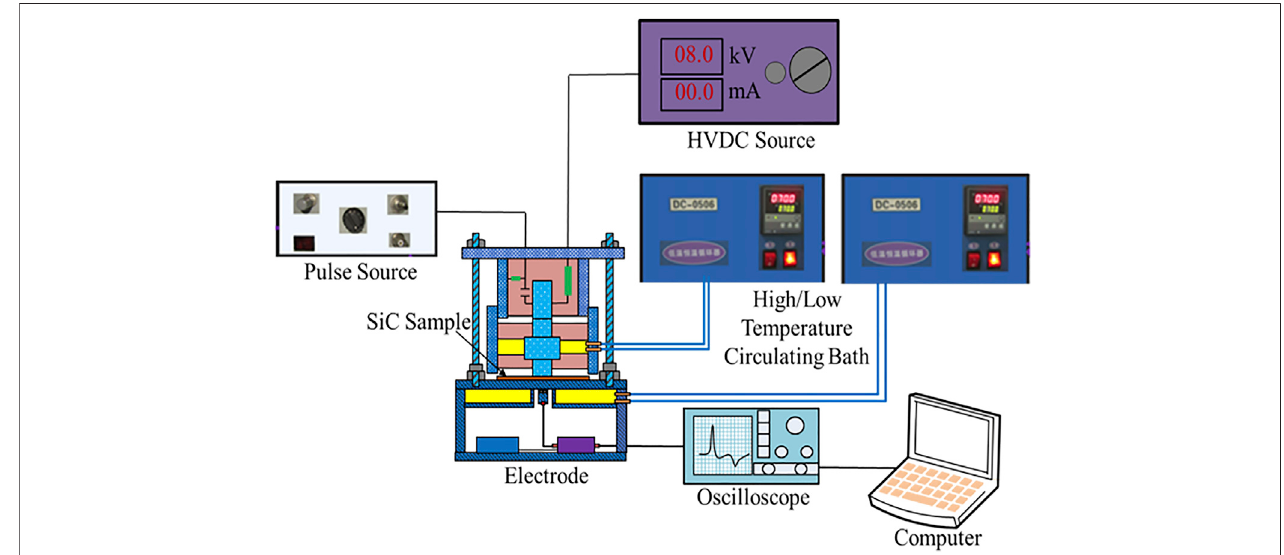
FIGURE 1 | Schematic diagram of PEA space charge measuring system for the SiC – epoxy